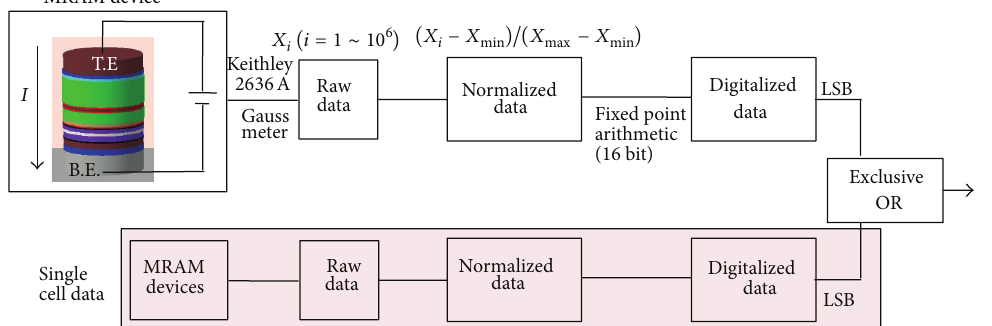
Figure2:SchematicdiagramshowingschemeforgeneratingrandombitsequenceusingthepMTJ.TheDCcurrentsareappliedtothepMTJs, flowing from the pinned to the free layer. A constant, positive magnetic field (100Oe) is simultaneously applied by a gauss-meter to correct the shift field. Electrical output signals for spin magnetization arrangements are extracted at 20 kbps using a Keithley 2636 A sourcemeter. The output voltage signals 𝑋 𝑖 (𝑖 = 1 – 10 6 ) are normalized to the form (𝑋 𝑖 − 𝑋 min )/(𝑋 max − 𝑋 min ) . The normalized signals are digitized using fixed-point arithmetic (16-bit). The least signification bits (LSBs) of the digitalized signal are used for binary signals. Finally, the binary signals obtained from the pMTJs are combined using an exclusive OR (XOR) method to generate a bit sequence. The single cell data method refers to data processing in only one pMTJ before the XOR